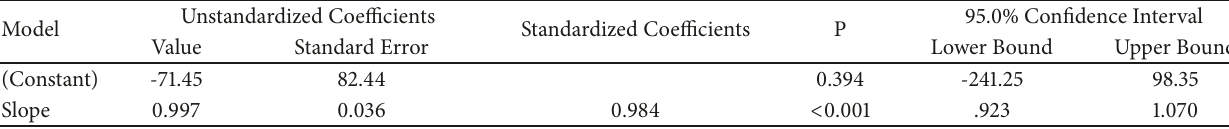
Table 2: Statistical parameters of linear regression analysis.